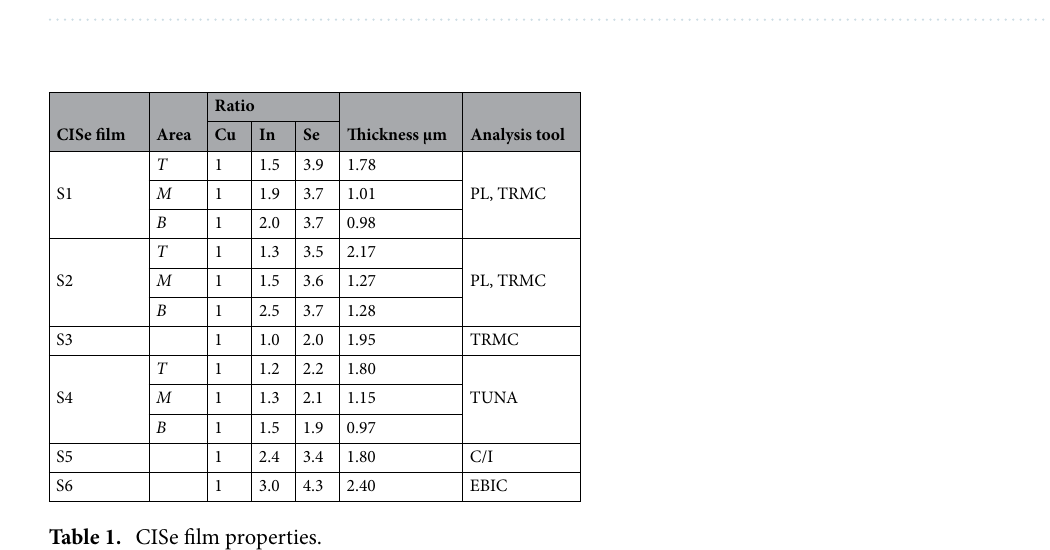
Figure 1. SSE of CISe from Cu + /In 3+ /Se 4 electrolyte on top ( T ), middle ( M ) and bottom ( B ) sections of foil electrode.